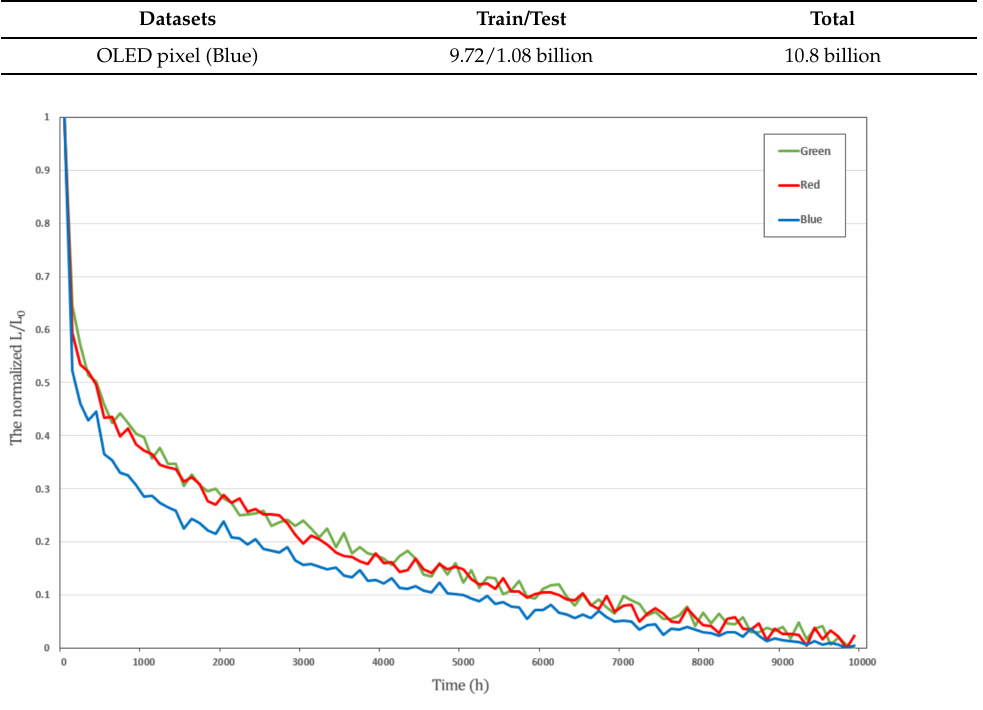
Figure 7. Luminance-degradation rate for normalized blue, red, and green pixel